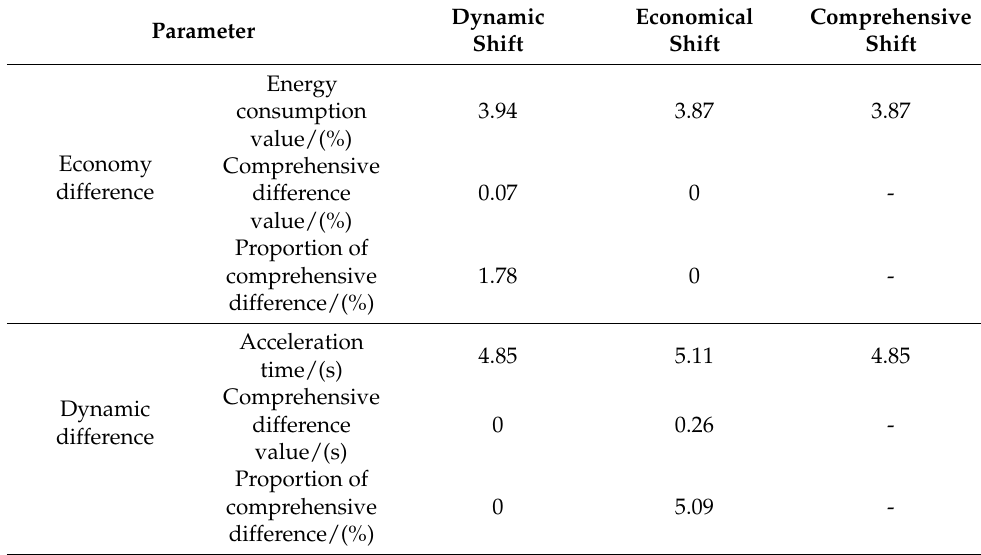
Table 2. The results of the economic and dynamic